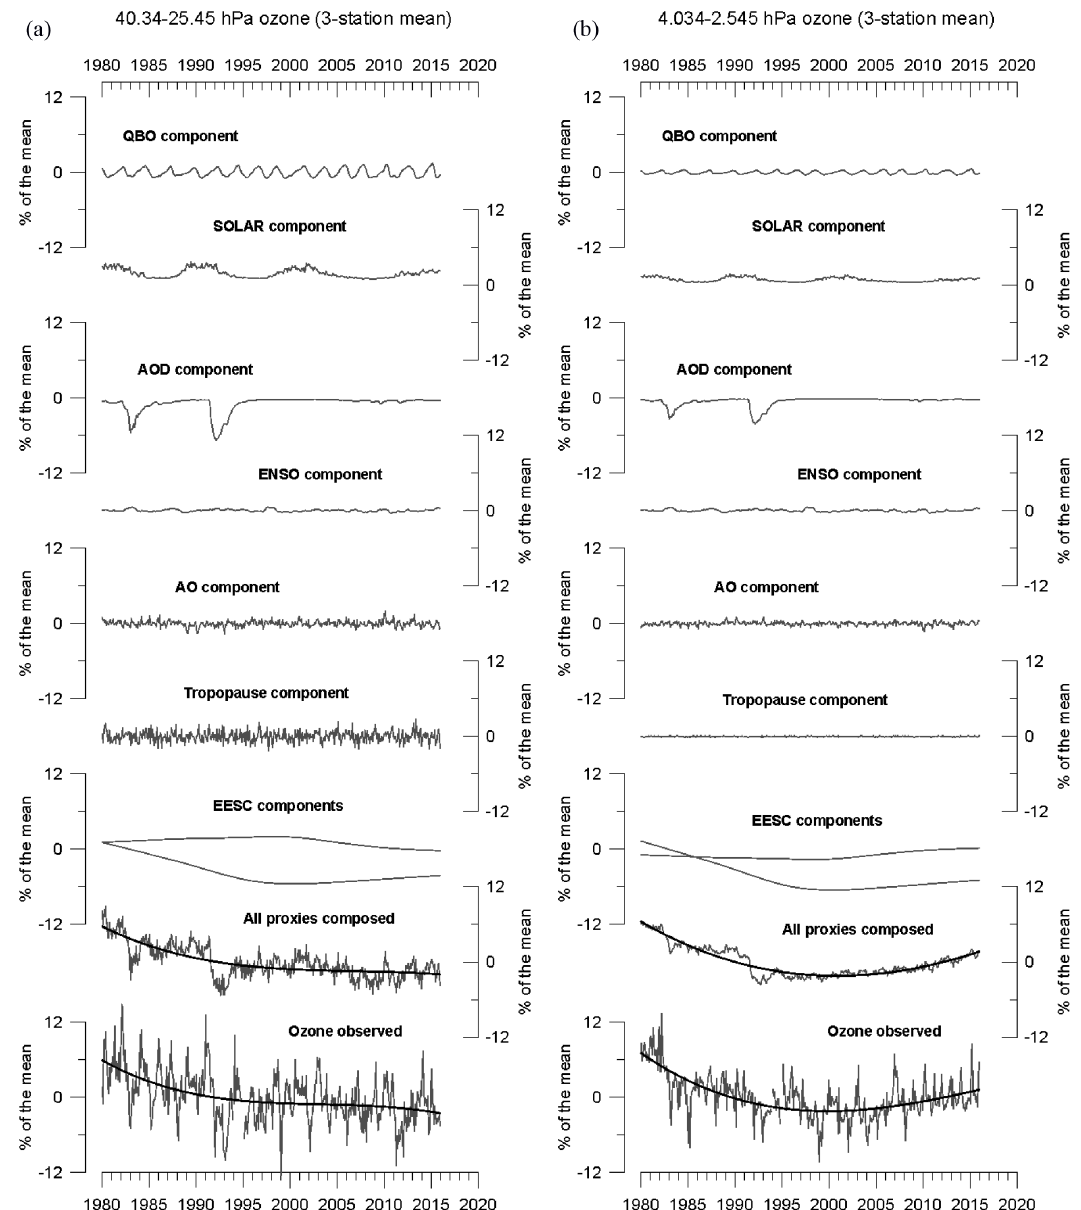
Figure 5. (a) Ozone variations attributed to the different proxies (QBO, SOLAR, AOD, ENSO, AO, tropopause pressure, EESC and its orthogonal function) at layer 8 (40.34–25.45hPa, centred at about 24km height) for SBUV overpasses averaged over Hohenpeißenberg, Haute Provence and Table Mountain. (b) Same as in (a) but for layer 13 (4.034–2.545hPa) centred at about 40km height. The lower most curves give the observed deseasonalized SBUV time series. Thick solid curves in the four bottom panels are third degree polynomials fit to the